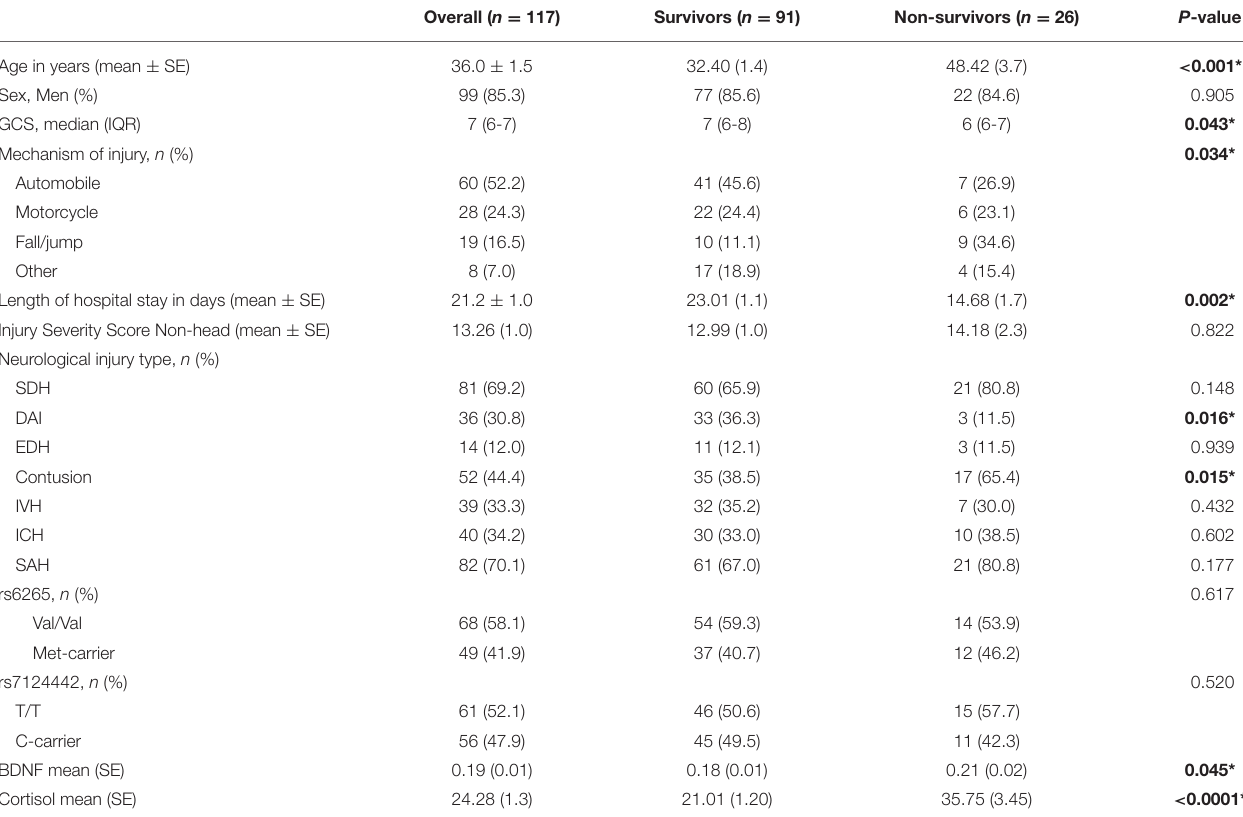
TABLE 1 | Demographic and clinical characterization of the